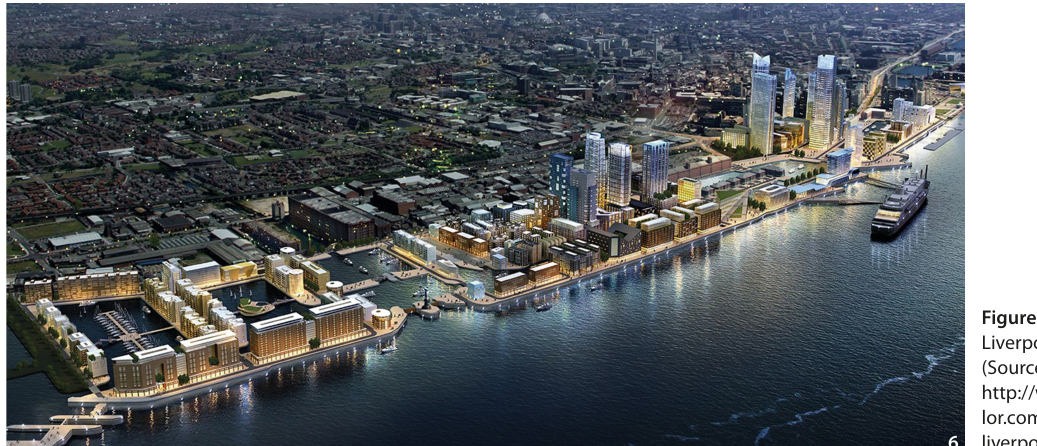
Figure 6 The proposed Liverpool Waters Scheme (Source: Chapman Taylor, http://www.chapmantay- lor.com/en/projects/detail/